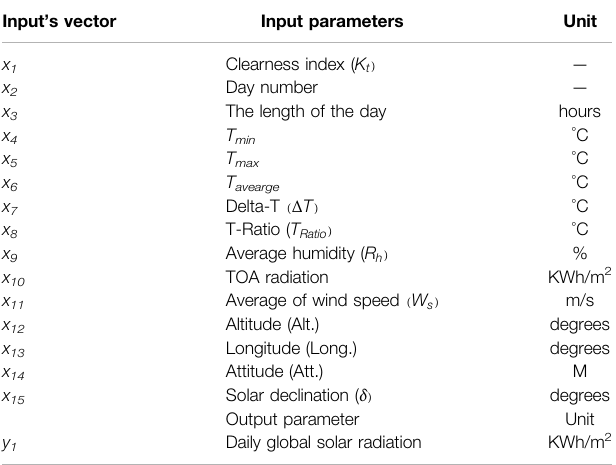
TABLE 3 | Climatological and geographical